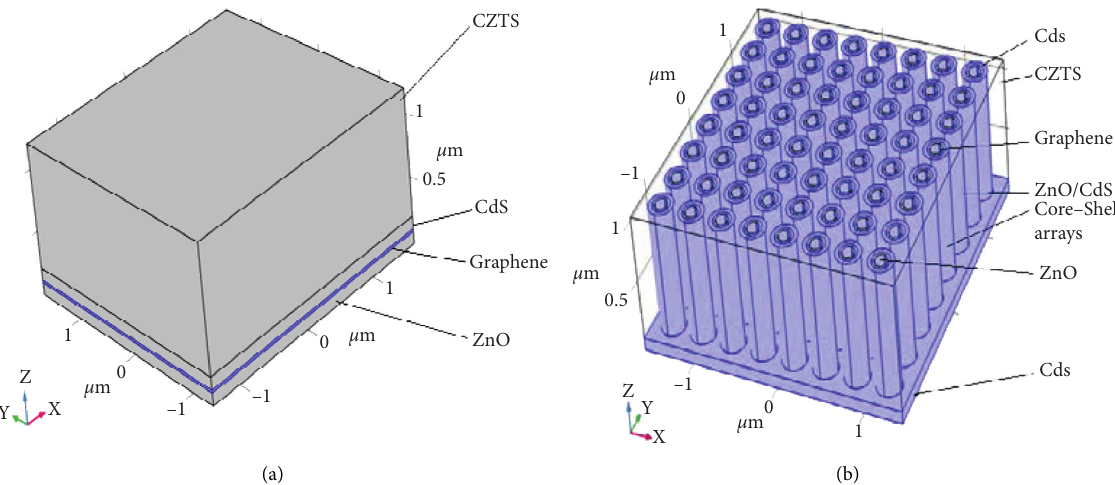
Figure 1: Structure models of (a) thin-film solar cells of ZnO/graphene/CdS/CZTS and (b) nanowire solar cell of ZnO/CdS core-shell array in CZTS film .